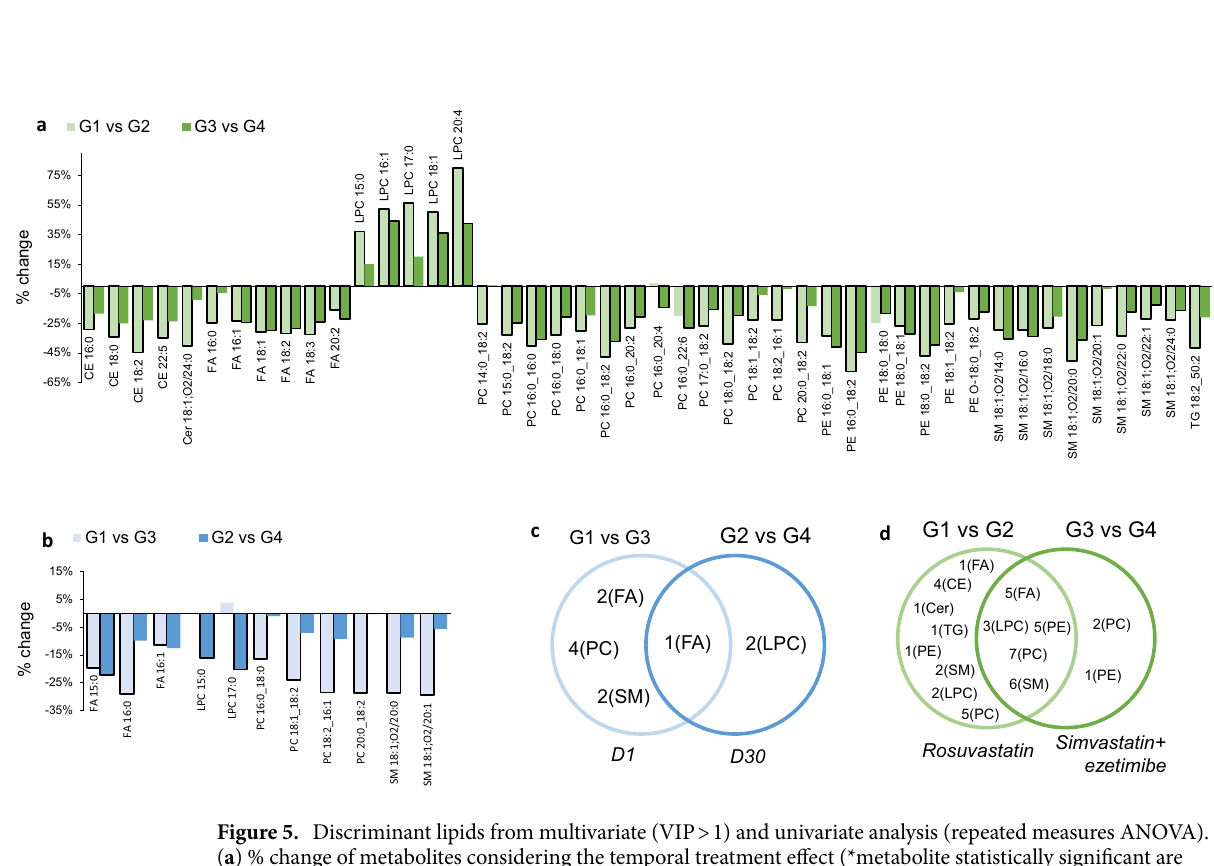
Figure 4. OPLS-DA scores plot (PC1 vs PC2) of all infarcted patients in the four groups considered. G1: Patients randomized to the rosuvastatin group at first day after myocardial infarction (D1); G2: Patients treated by rosuvastatin after 30 days of treatment (D30); G3: Patients randomized to the simvastatin plus ezetimibe group at the first day after myocardial infarction (D1); G4: Patients treated by simvastatin plus ezetimibe after 30 days (D30). Figure was created in SIMCA 16 (Statistical Software Package, Umetrics, Sweden; URL: http:// umetr ics. com/ produ ct/ simca).